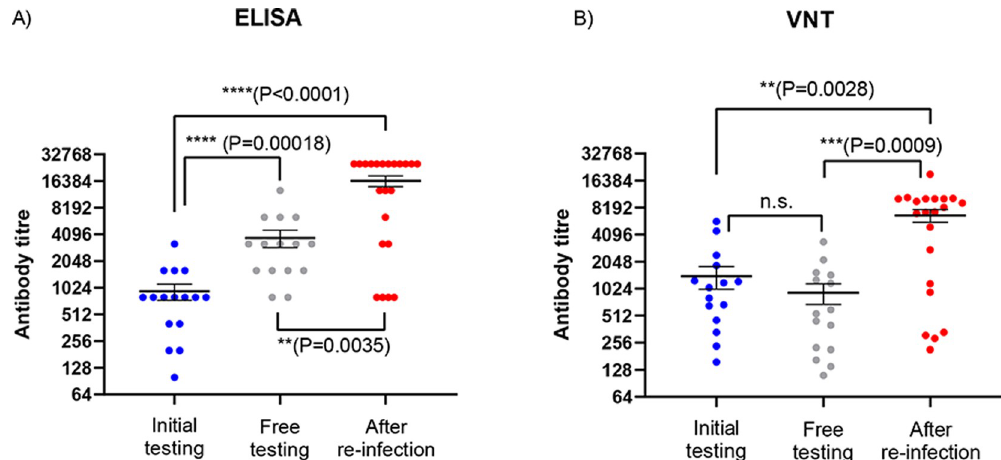
Fig 2. Assessment of anti-SARS CoV-2 antibody levels in mink sera. Panel A. Anti-SARS-CoV-2 antibody titres were measured by ELISA. Selected sera from mink collected at the time of initial diagnosis (blue circles), at free-testing (grey circles) and following re-infection (red circles), on 19-08-20, 05-10-20 and 06-11-20 respectively, that scored positive when assayed undiluted were titrated and assayed again by ELISA. The reciprocals of the highest dilution yielding a positive signal are plotted (on a log2 scale). Mean (+/- SEM) values are indicated by horizontal black lines. Panel B. The same serum samples were also assayed in virus neutralization assays and the calculated antibody titres are plotted (on a log2 scale) using the same colour scheme. The statistical significance of the differences between anti-CoV-2 antibody levels was determined using the Kruskal-Wallis test (see Materials and Methods).